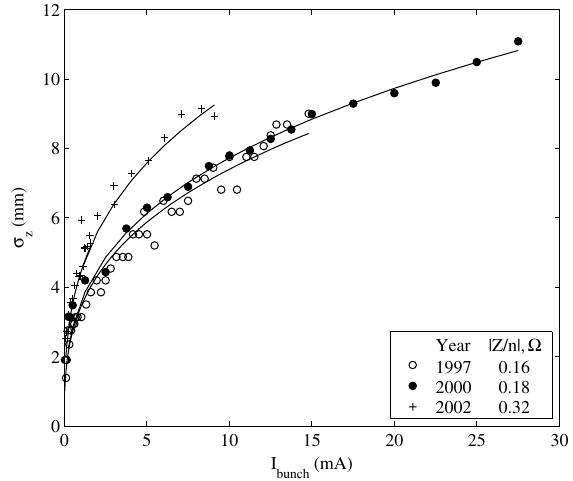
FIG. 4. Bunch lengthening versus